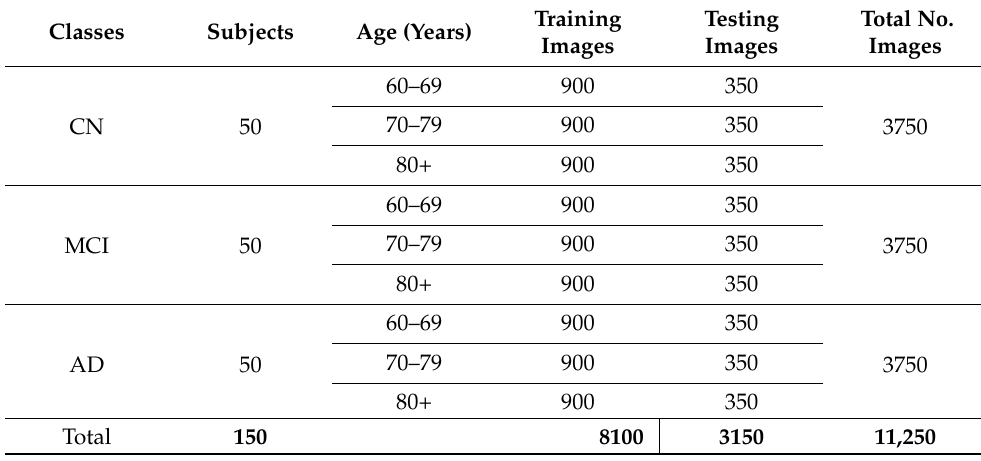
Table 1. Data distributions.